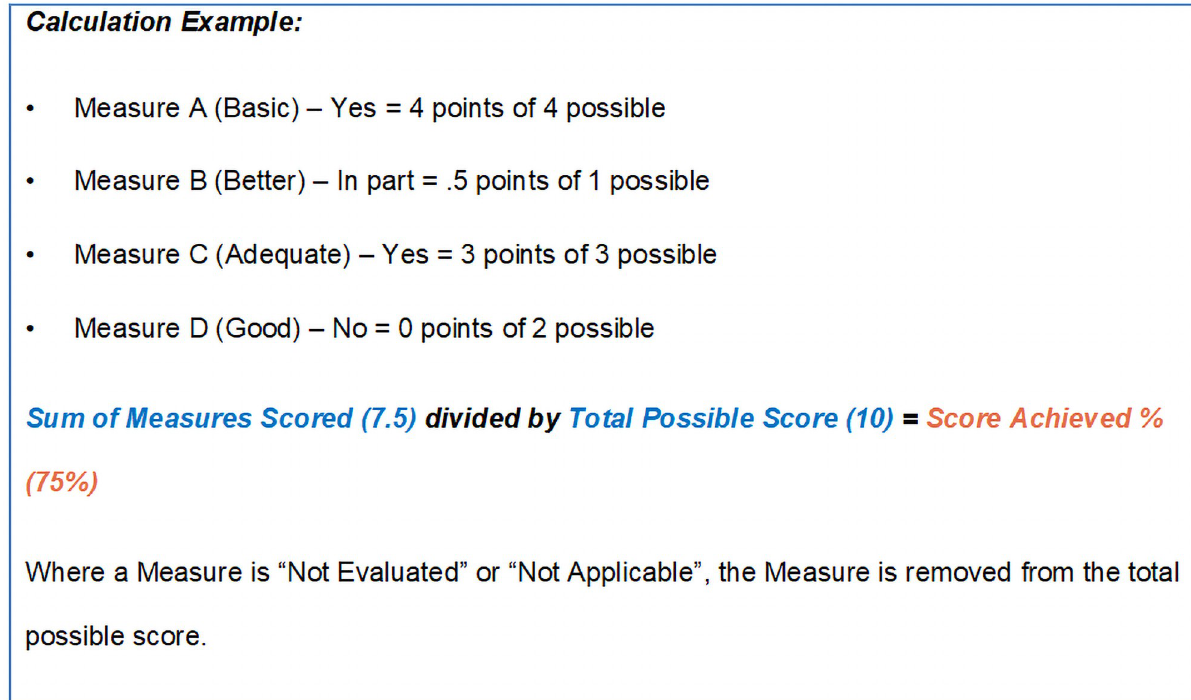
Fig 3. Simplified illustrative calculation of an overall score based on measures scored.